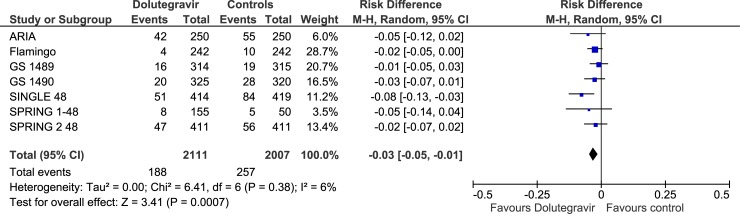
Forest plot of comparison.Dolutegravir vs comparators, outcome: Overall rate of discontinuation.